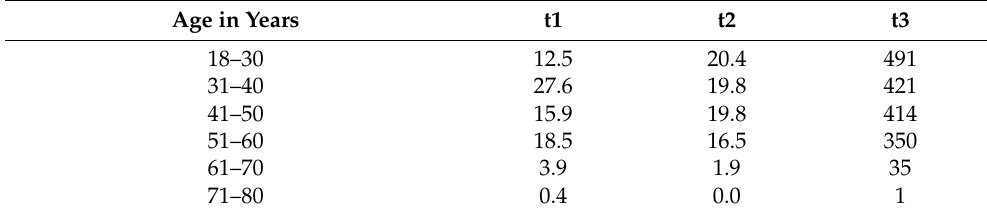
Table 3. Age distribution at two